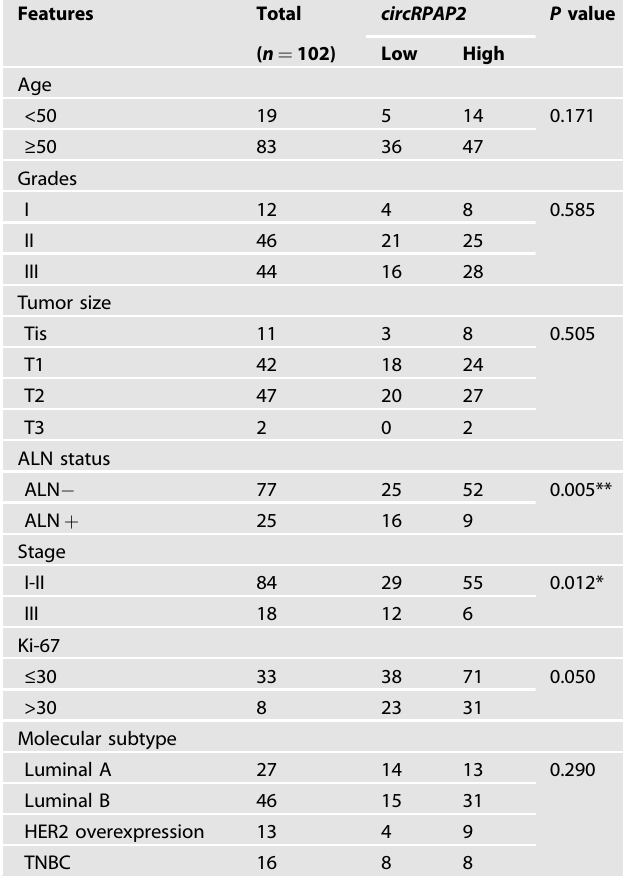
Table 1. Relationships between circRPAP2 expression and clinical features of patients with